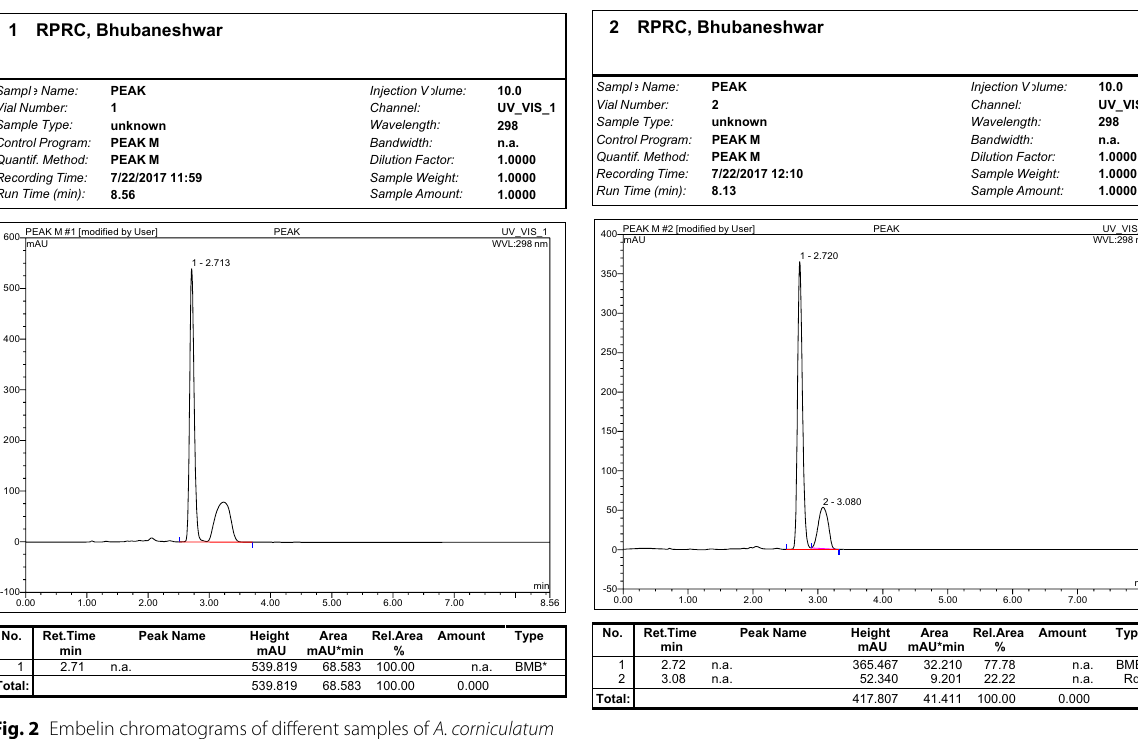
Fig. 2 Embelin chromatograms of different samples of A.